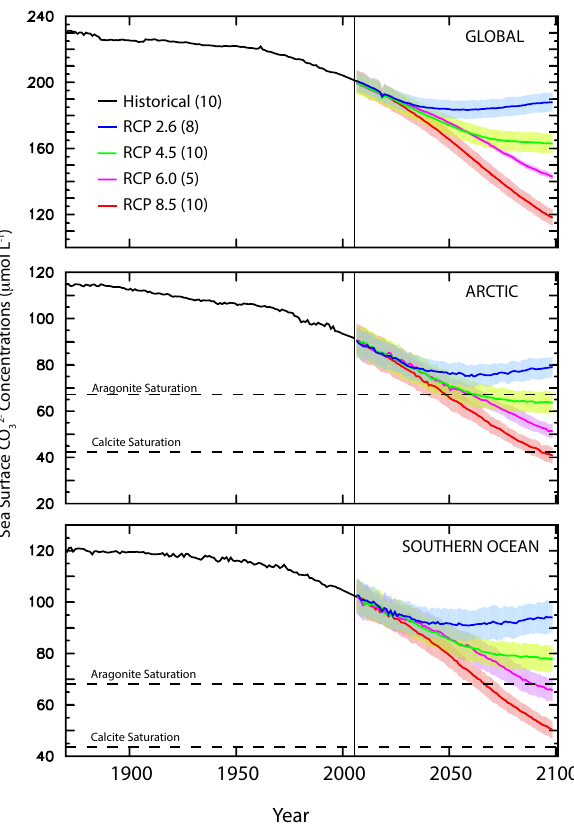
Fig. 7. Model-mean time series of mean surface carbonate ion concentrations (µmolL − 1 ) for the global ocean, the Arctic Ocean (north of 70 ◦ N), and the Southern Ocean (south of 60 ◦ S) over 1870–2100 using historical simulations as well as all RCP simula- tions. Also indicated are estimates of aragonite and calcite satura- tion levels for the Arctic and the Southern oceans (dashed lines).